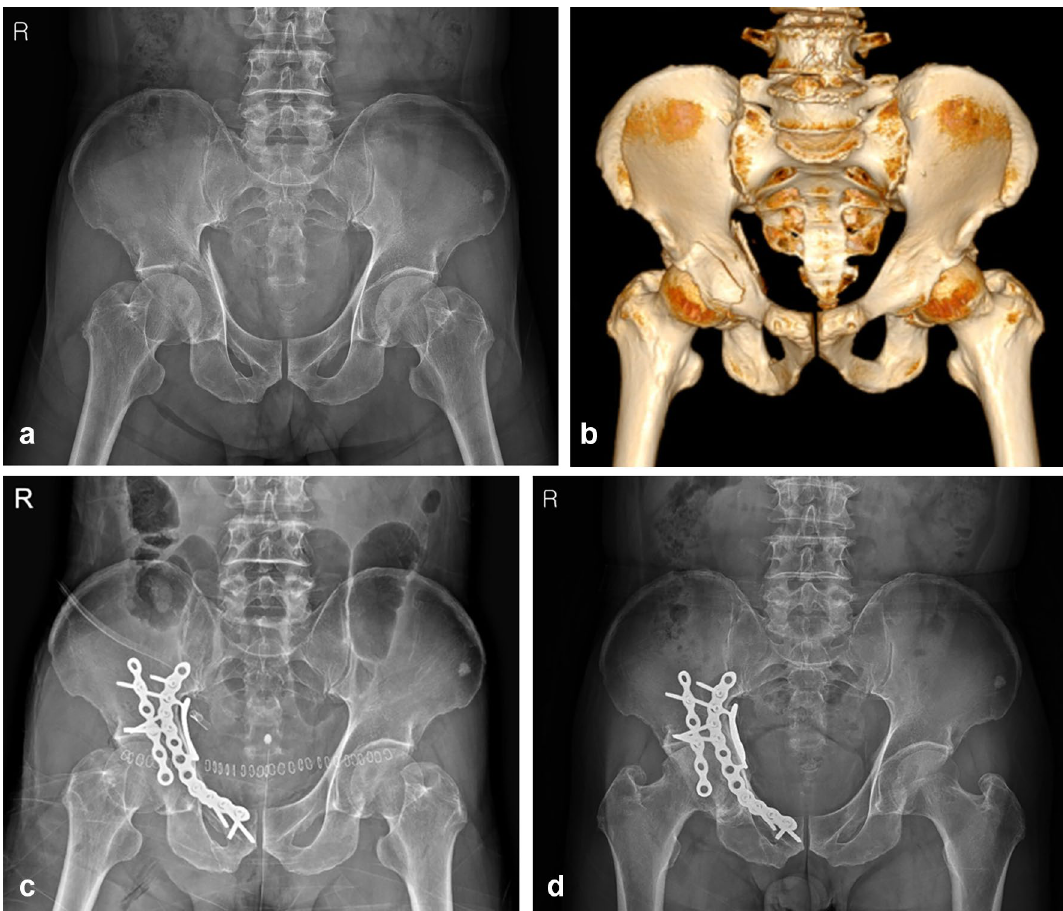
Figure 9. ( a ) pelvis anteroposterior radiograph and ( b ) 3D-CT of a 67-year-old male, superomedially displaced acetabular fracture with anterior wall fragment. ( c ) Immediate postoperative and ( d ) 18 months after surgery radiograph, after fixed with quadrilateral surface plate and additional buttress